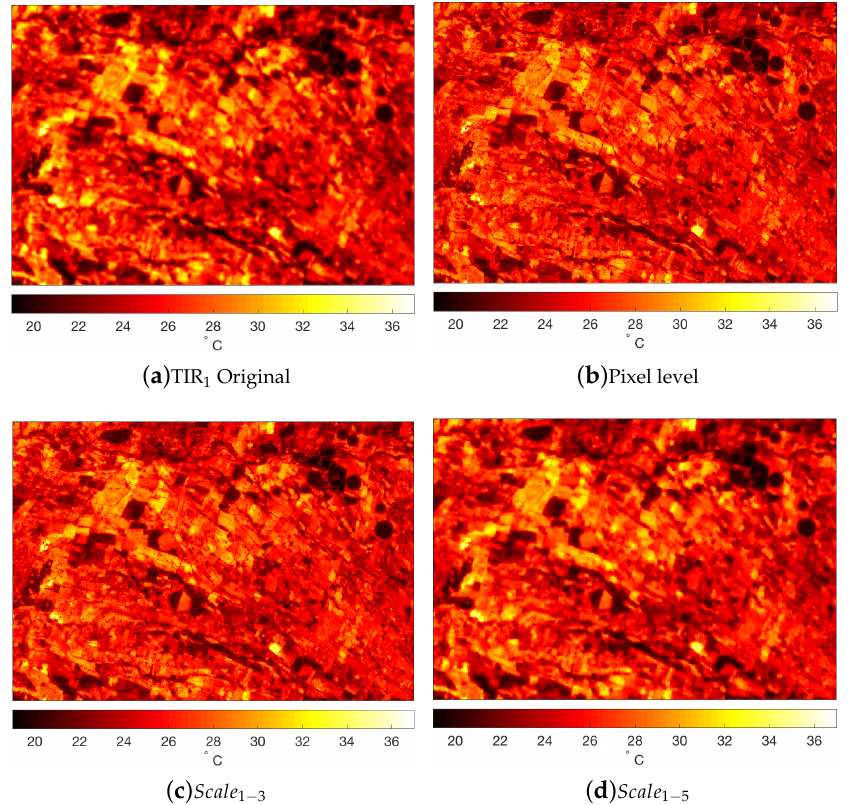
Figure 10. Influence of spatial context information on the sharpened images by TS 2 uRF. ( a ) Original image TIR 1 at 100 m spatial resolution (resampled at 30 m) and sharpened TIR 1 at 30 m spatial resolution by TS 2 uRF considering: ( b ) Pixel level; ( c ) Scale 1 − 3 and ( d ) Scale 1 − 5 as a spatial context